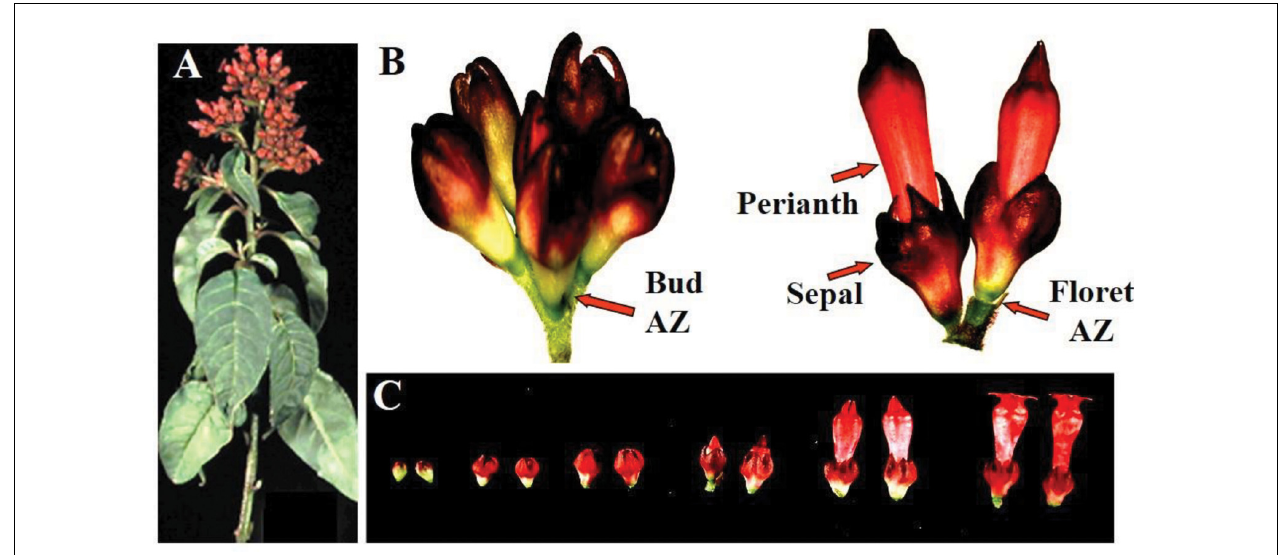
FIGURE 1 | Morphology of floret developmental stages in Red Cestrum cut flowers. A typical cut flowering shoot (A) ; definition of floral parts in an individual cluster of florets from an inflorescence head composed of florets at two developmental stages (B) ; and classification of floret buds developmental stages (C) .